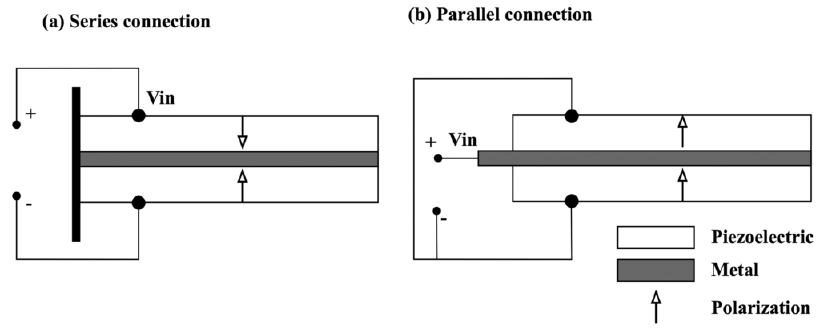
Figure A2. Piezoelectric bimorph connected in series and in parallel.